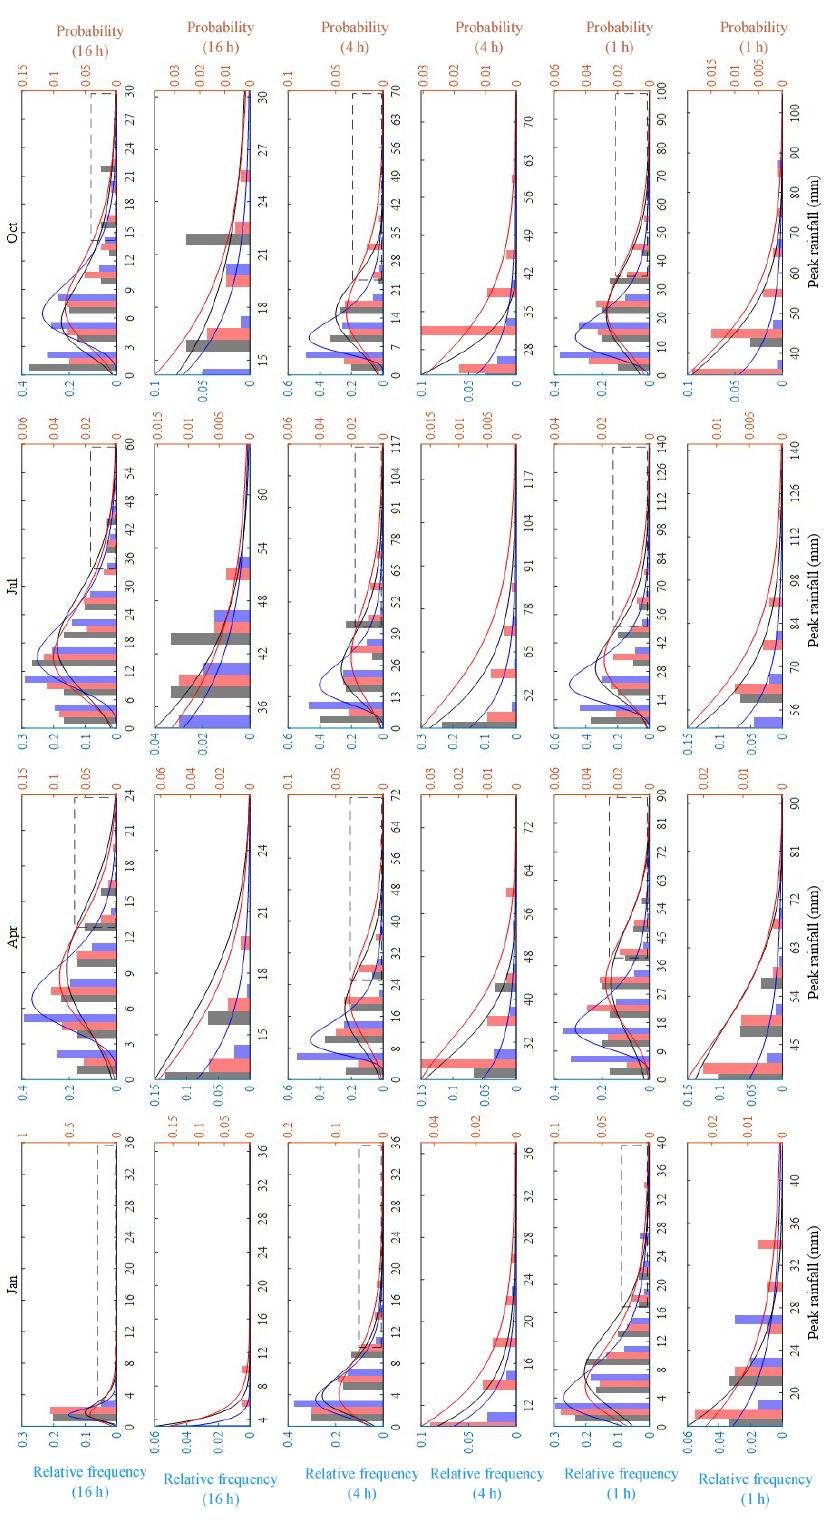
Figure 15. Relative frequency and the fitted GEV distribution of the 1, 4, and 16h monthly maxima of January, April, July, and October rainfall at NCDC gauge 132203. Results of observed rainfall (black), our hybrid model (red), and the traditional MBLRP model (blue) are shown. The upper 10th percentile of the distribution (dashed box in the plots in the first, third, and fifth row) is magnified in the lower rows (plots in the second, fourth, and sixth